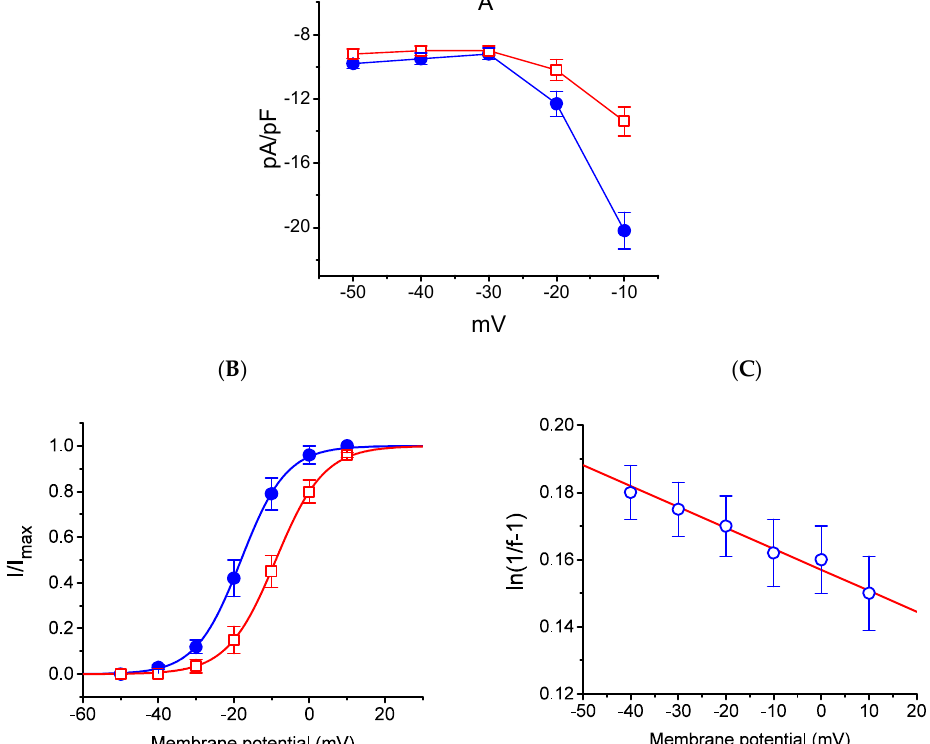
Figure 5. E ff ect of HBA on the average current density–voltage relations of I K(M) density ( A ), the steady-state activation curve of I K(M) ( B ), and the voltage-dependence of HBA-induced blocking of the current ( C ) in GH 3 cells. Cells were bathed in high-K + , Ca 2 + -free solution and the pipette was filled with K + -containing solution. Once the whole-cell model was established, the examined cell was held at − 50 mV and various voltages ranging between − 50 and + 10 mV were applied. (A) The relationship between I K(M) density and membrane potential obtained in the presence ( (cid:8) blue) and presence ( (cid:3) red) of 10 µ M HBA (mean ± SEM; n = 9 for each point). ( B ) The activation curve of I K(M) in the absence ( (cid:8) blue) and presence ( (cid:3) red) of 10 µ M HBA (mean ± SEM; n = 11 for each point). The smooth curves obtained with or without the addition of HBA were least-squares fitted by a Boltzmann function as detailed in the Materials and Methods Section. ( C ) Voltage dependence for HBA-induced blocking of I K(M) in GH 3 cells (mean ± SEM; n = 10–11 for each point). The line overlaid onto the data was fitted using the equation as detailed in the Materials and Methods Section. The Kd value (the equilibrium constant at 0 mV) and δ (the relative electrical distance of the blocking site in the transmembrane electrical field) were estimated to be 11.7 µ M and 0.016,